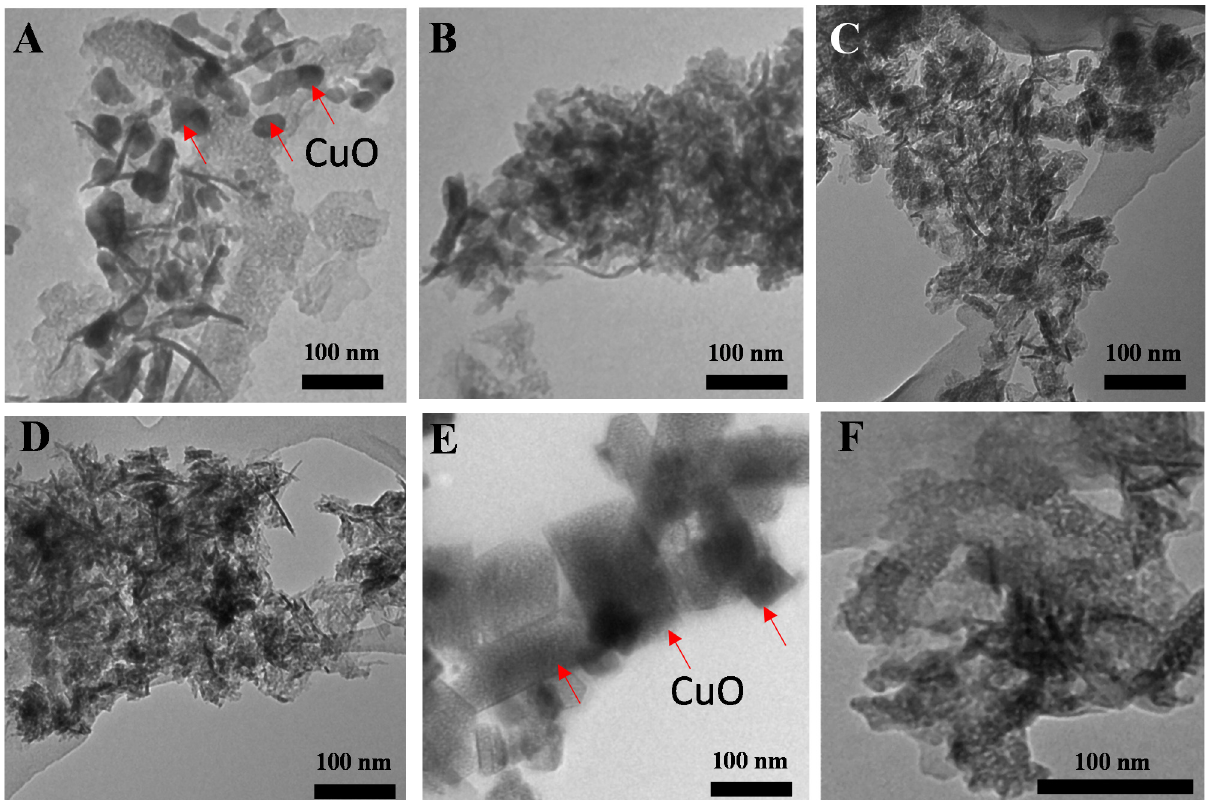
Figure 2. TEM images of the Cu-Ni/Al 2 O 4 samples synthesized under different pH conditions: ( A ) 6.0, ( B ) 7.0, ( C ) 8.0, ( D ) 9.0, ( E ) 10.0, and ( F ) higher magnification image of pH 8 sample. (Note that calcination temperature is 600 °C for all samples).